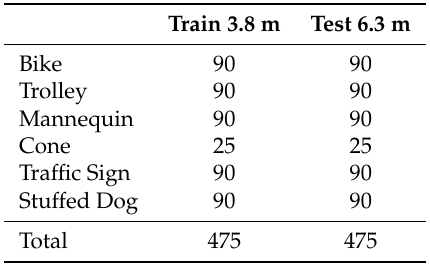
Table 1. Dataset collection showing the number of different raw images